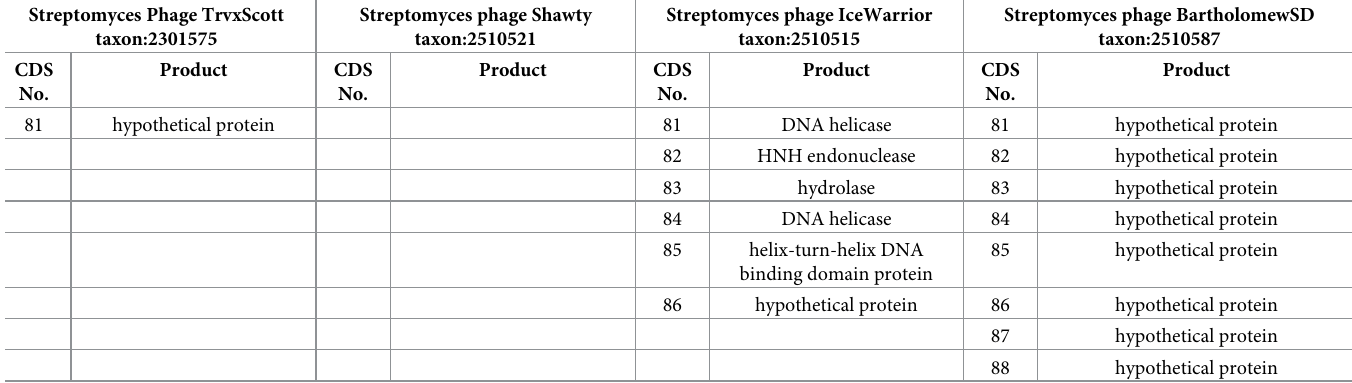
Table 9. General characteristics of predicted CRISPR-Cas systems within the genomes of strains DF, SFW, QF2, and JS. Strains CRISPR Spacers Repeats Spacers with Blastn Hits to Host Range Phage Cas Loci Cas-Associated Genes DF SFW